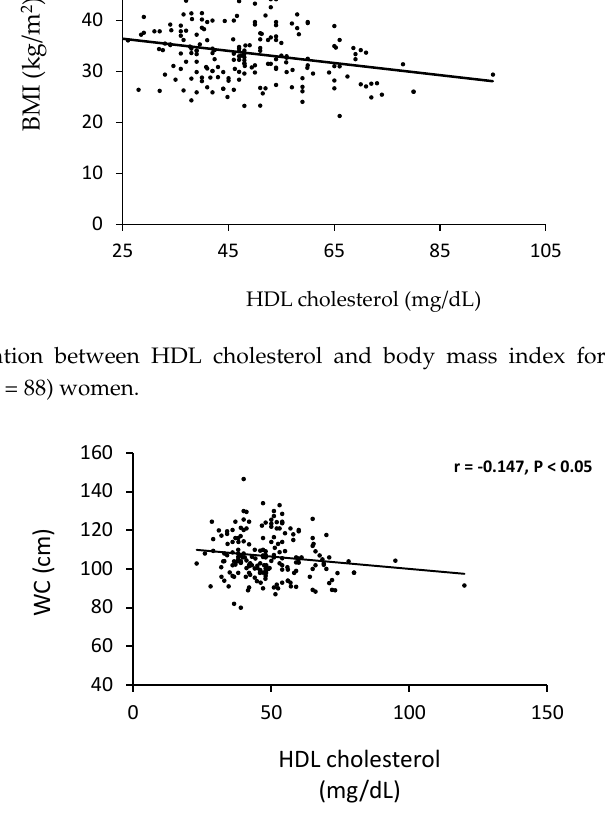
Figure 3. Correlation between HDL cholesterol and waist circumference in 100 pre and 88 post- menopausal women.